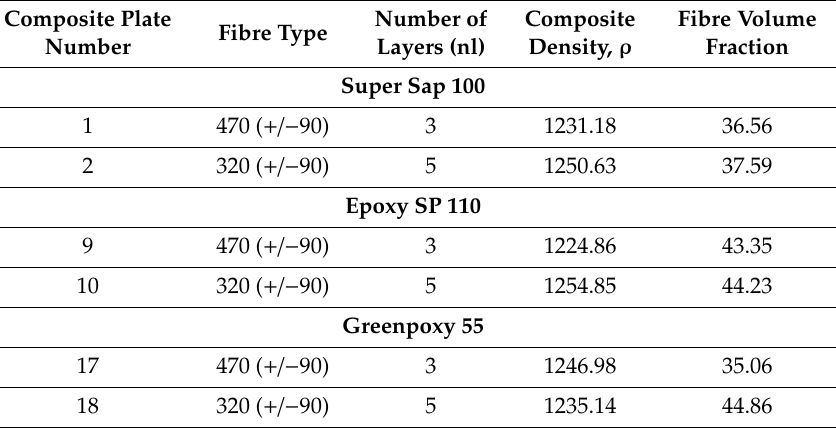
Table 1. General properties of hemp fibre-reinforced